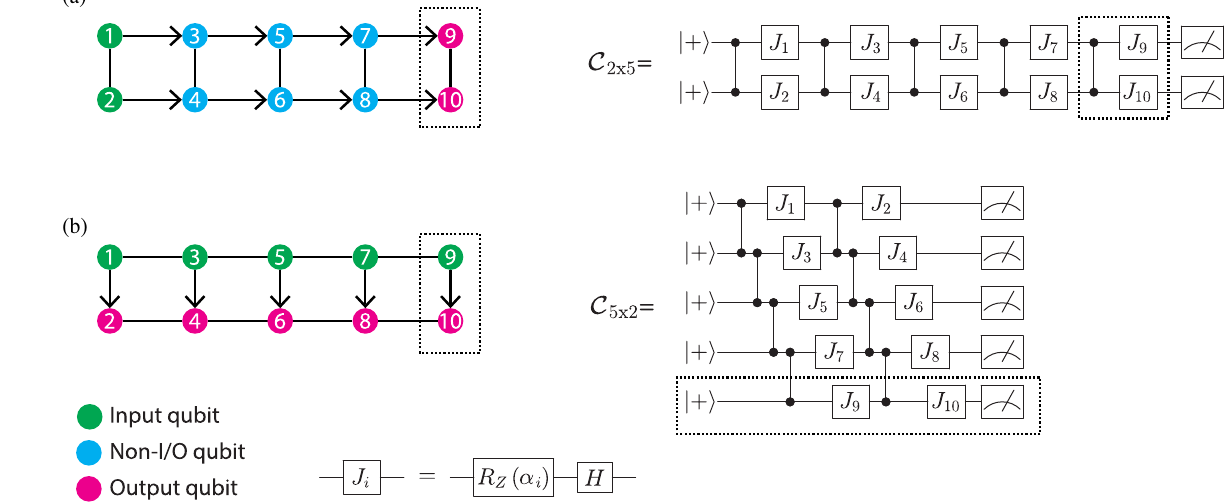
FIG. 8. Box cluster 2 × 5 with two choices of g-flow. In diagram (a), the “ left-to-right ” flow maps to the two-qubit, depth-5 circuit “ top-to-bottom ” flow maps to a five-qubit, depth-2 circuit C C 2 × 5 , whereas in diagram (b), is equivalent to the elements in dashed borders being